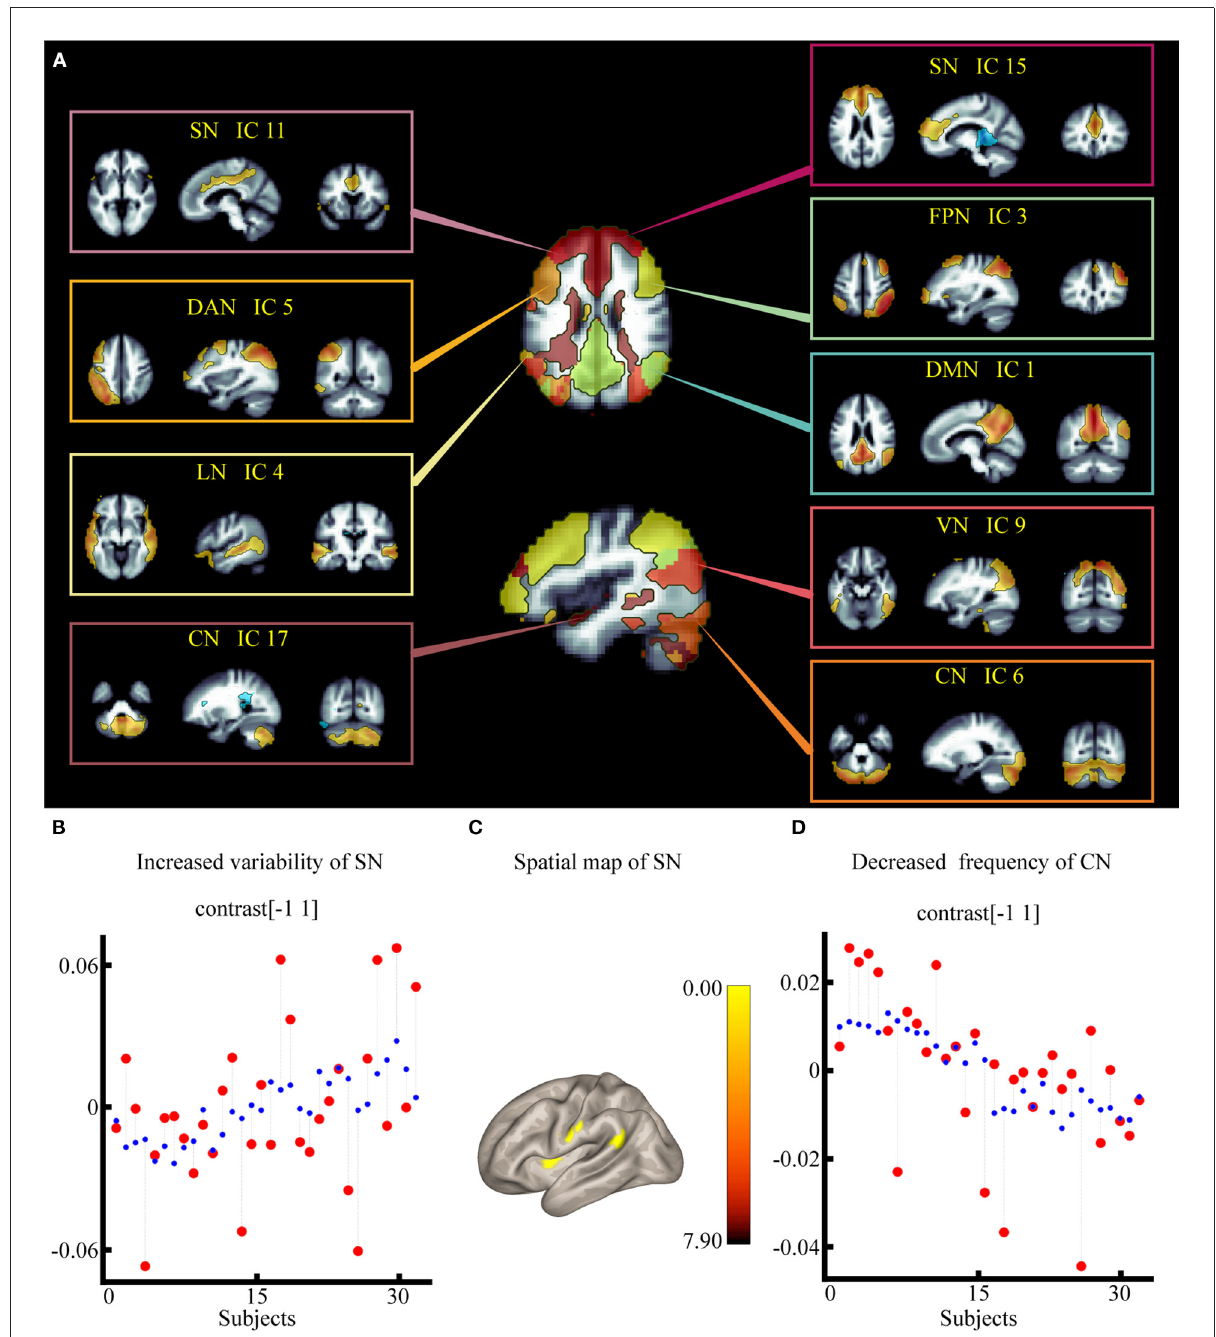
FIGURE3 Effect of electroacupuncture stimulation on static independent component analysis. (A) Nine spatial maps of intrinsic resting-state networks in 32 subjects. (B) Changes in temporal properties varies of SN within each group and condition. (C) Spatial map of SN for the contrast of post stroke aphasia group vs. healthy control group. (D) Changes in temporal properties varies of VN within each group and condition. DMN, default mode network; SMN, sensorimotor network; VN, visual network; SN, salience network; DAN, dorsal attention network; FPN, frontoparietal network; LN, language network; CN, cerebellar